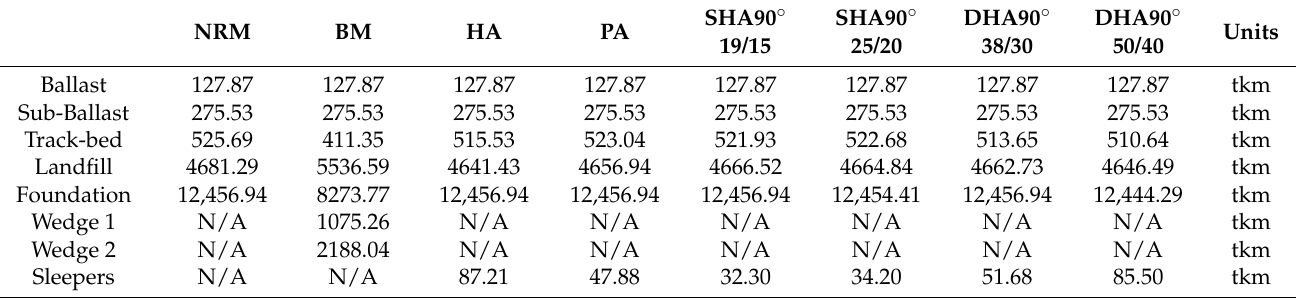
Table 3. Inventory of transport inputs for each reinforcement